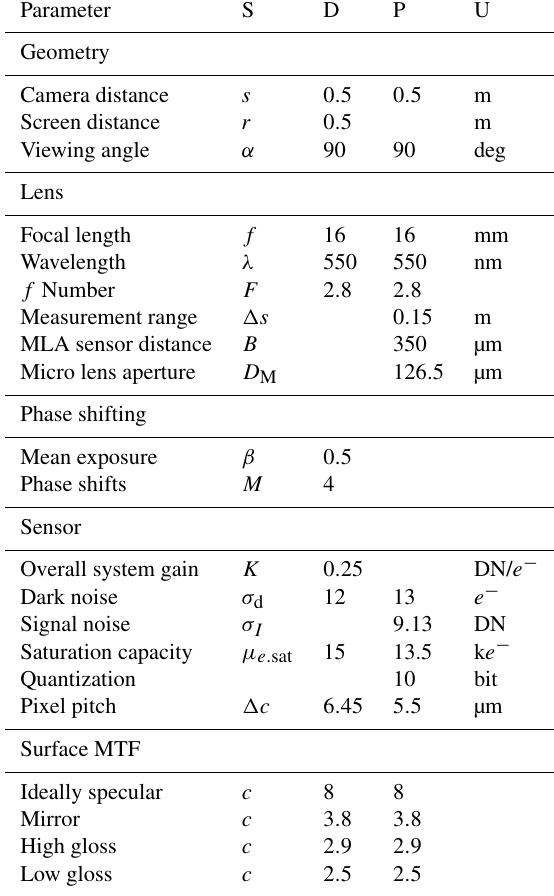
Table 1. Simulation parameters, with corresponding symbols (S) for deflectometry (D), plenoptic (P) and units